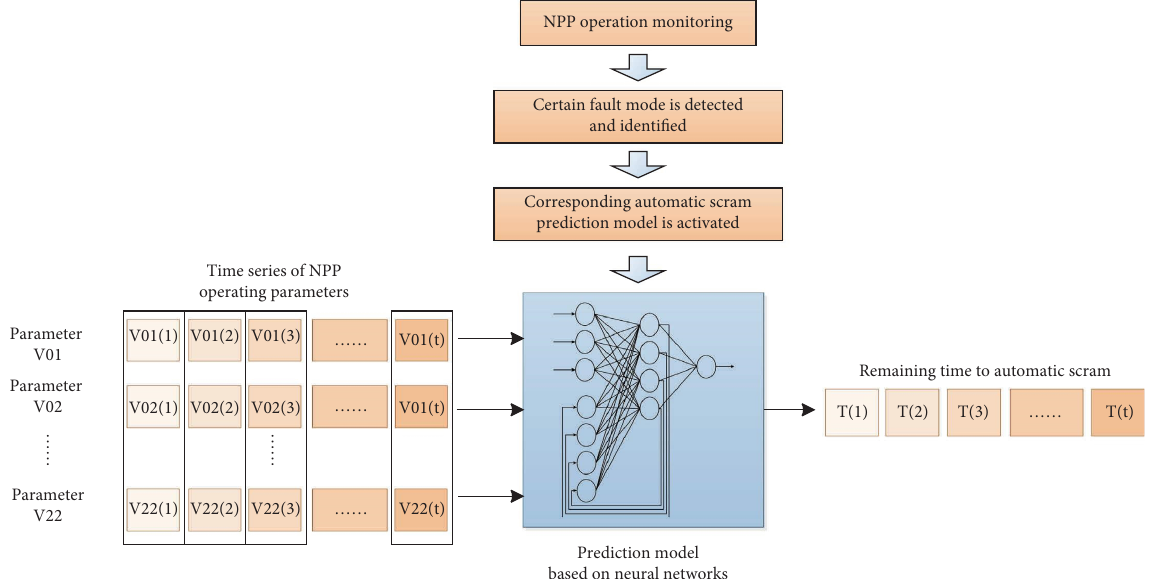
Figure 1: Te process of automatic scram prediction.